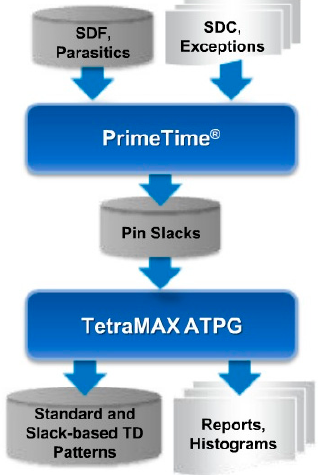
Figure 19. Synopsys flow from PrimeTime to TetraMax ATPG.